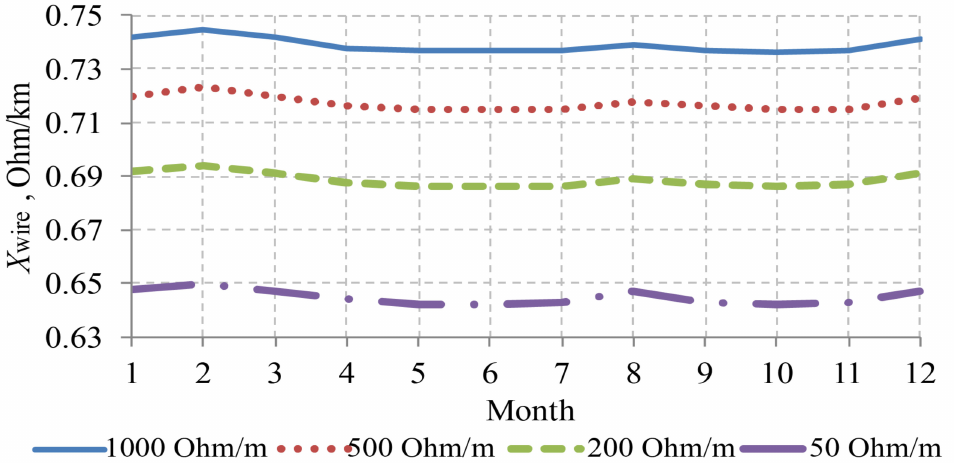
Figure 6. Relationship between the wire reactance and different soil resistances from seasonal fluctuations in humidity and